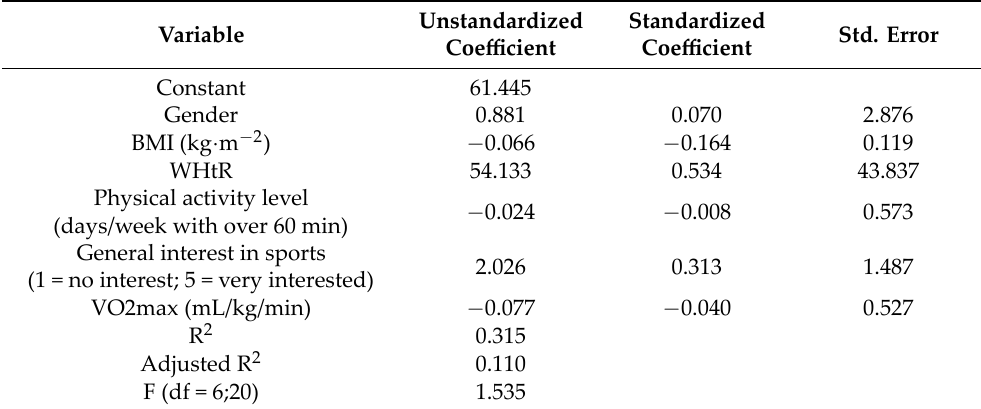
Table 2. Effects of gender, BMI, WHtR, weekly activity level, general interest in sports, and VO 2 max on perceived enjoyment during the exergaming session.